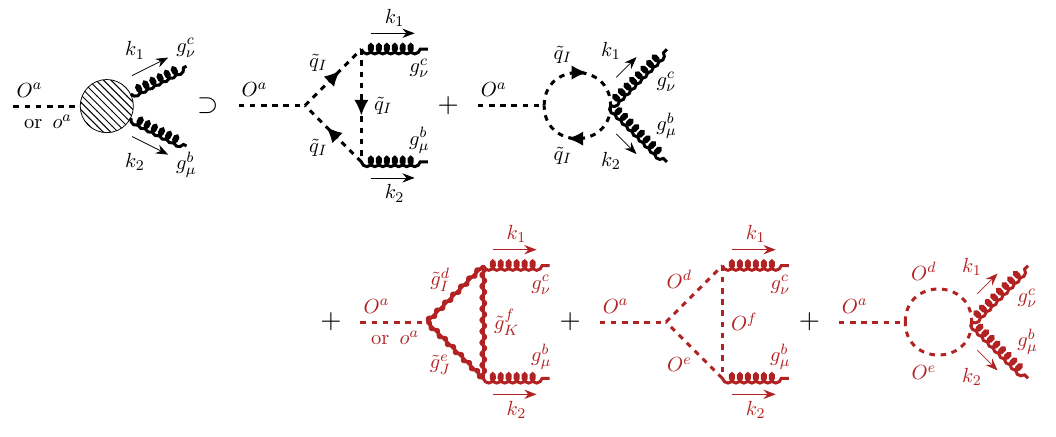
Figure 2. Representative diagrams for sgluon decays to gluons. Both ˜ q L and ˜ q R (hence any combination of ˜ t 1 and ˜ t 2 ) can run in the squark loops. Additional sgluon loops exist with O → o . Not displayed are triangle diagrams with exchanged final-state gluons. Red diagrams vanish if R symmetry is